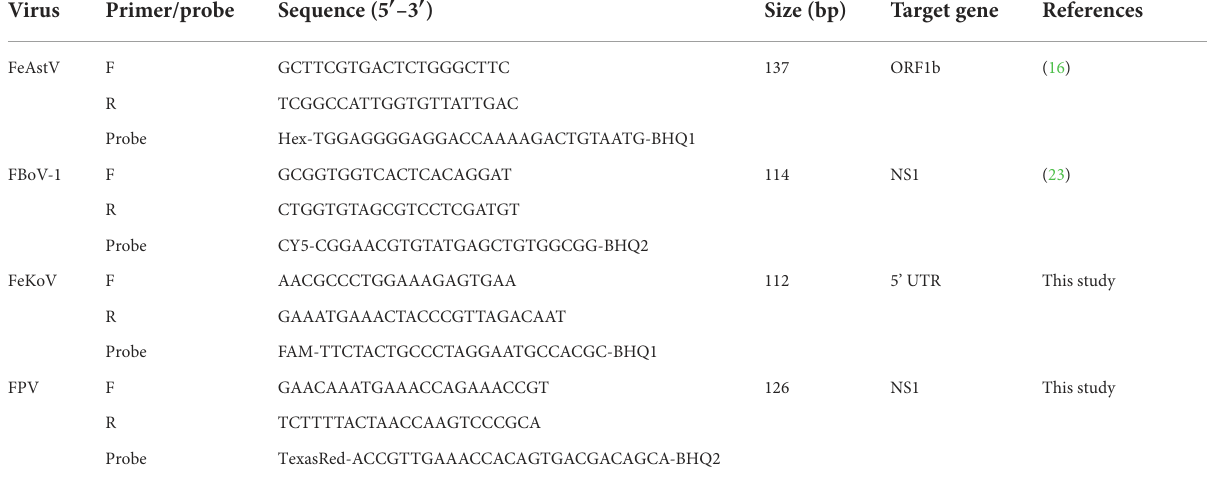
TABLE 1 Primers and probes designed for the multiplex